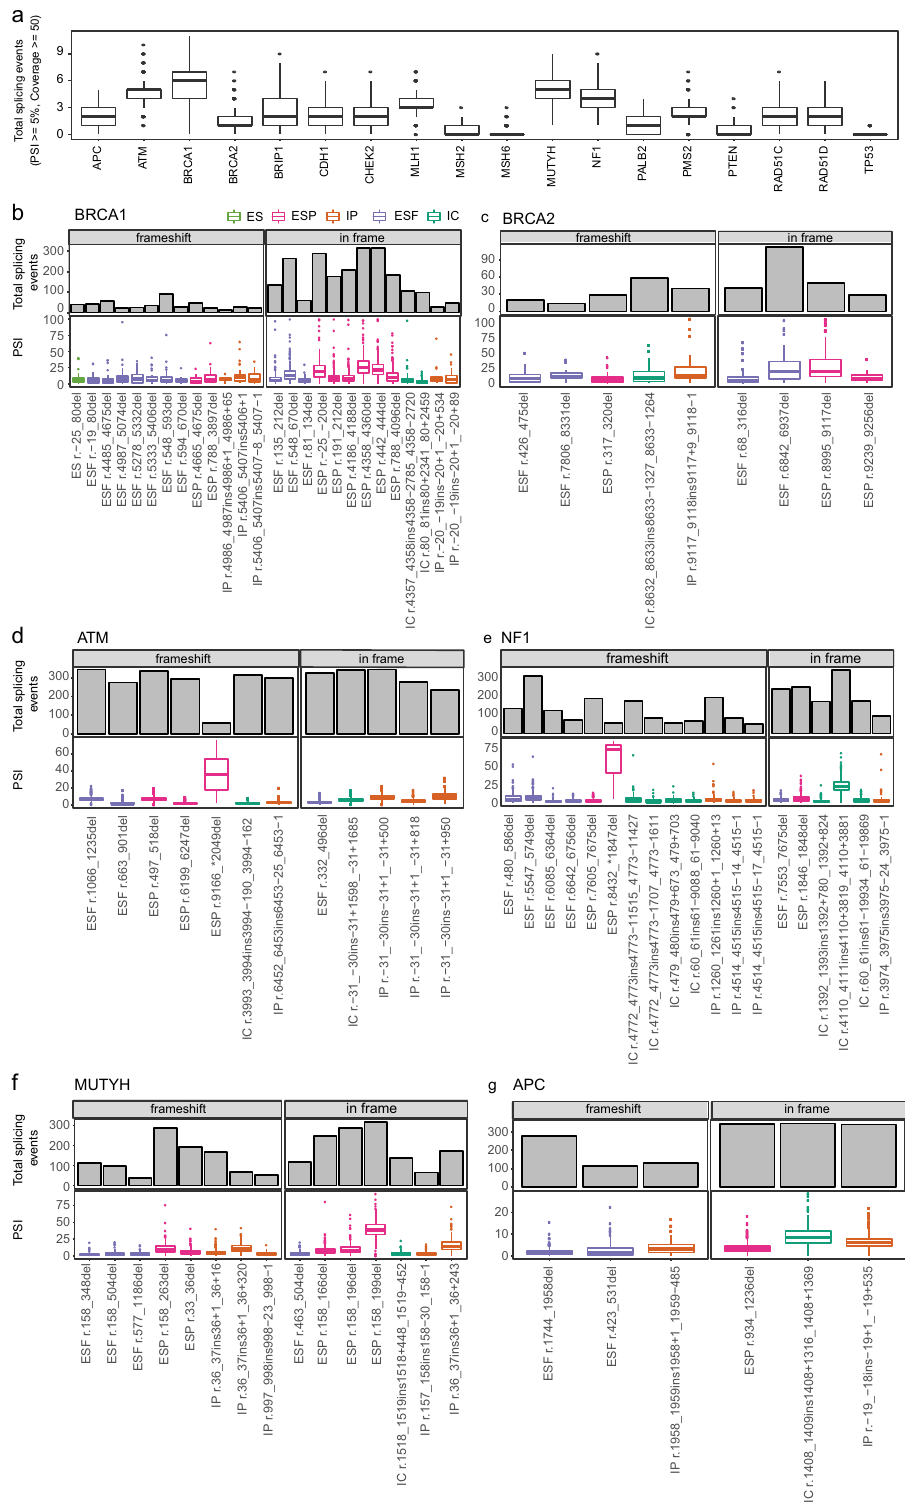
Fig. 2 Healthy controls ’ alternative splicing events detected in TSG. a Boxplot indicating median number of splicing events across controls with ≥ 5% PSI and coverage ≥ 50× for each hereditary cancer predisposition gene tested. b – g Plots indicating frequency (bar graph) and median PSI with interquartile range (boxplot) for alternative splicing events with PSI ≥ 5 in ≥ 5% of controls (17/345 controls). For each gene, alternative splicing events are divided into in-frame and frameshift transcripts. Splicing events are as follows: ES = exon skipping — a combination of a full and partial exon skipping event, ESF = full exon skipping — the entire length of the exon is skipped, ESP = partial exon skipping — some portion of the exon is skipped (i.e., alternative acceptor/donor), IC = cryptic exon — an intronic insertion (split reads on 5 ′ and 3 ′ end), IP = partial intronic insertion — an extension of the exon into the intron either upstream (5 ′ ) or downstream (3 ′ ) of the exon. b – d Hereditary breast and ovarian cancer genes ( BRCA1/BRCA2/ATM ), e NF1 , and f , g colorectal/polyposis genes ’ ( APC / MUTYH ) alternative splicing